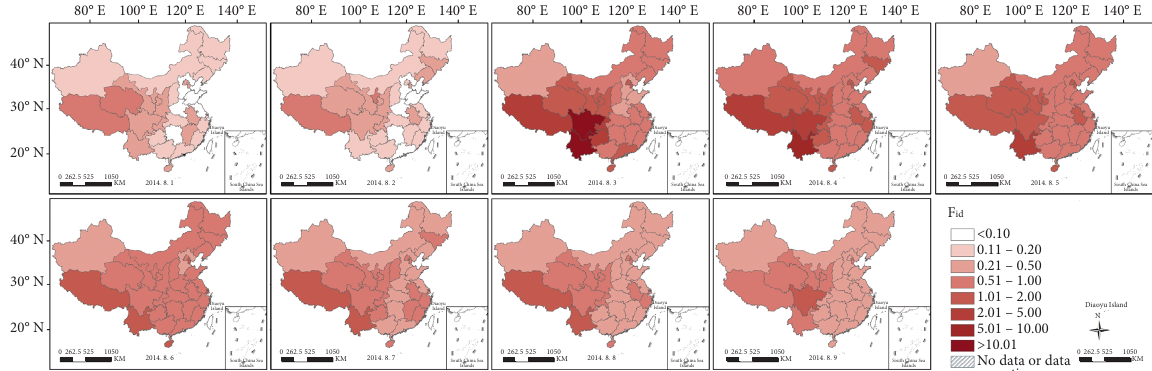
Figure 4: F id before and after the Ludian earthquake (8/1/2014–8/9/2014).